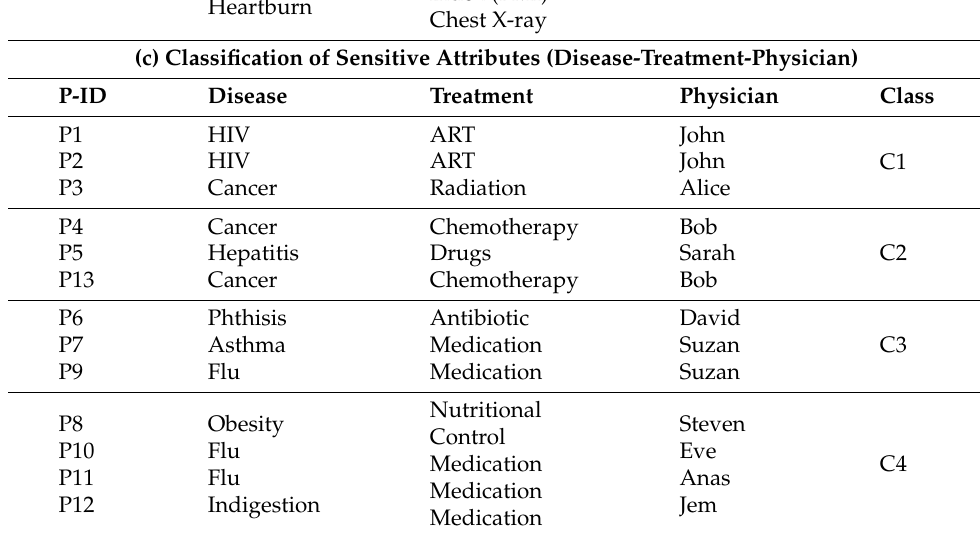
(c) Classification of Sensitive Attributes